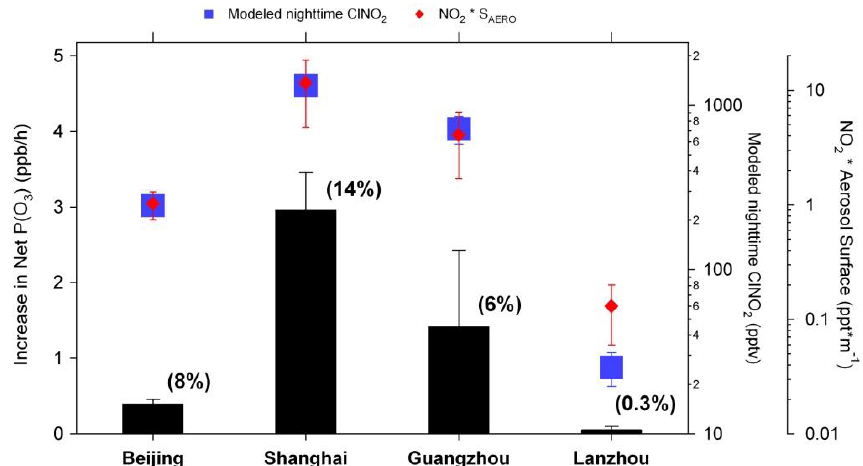
= 0 . 6) during episodes at 2